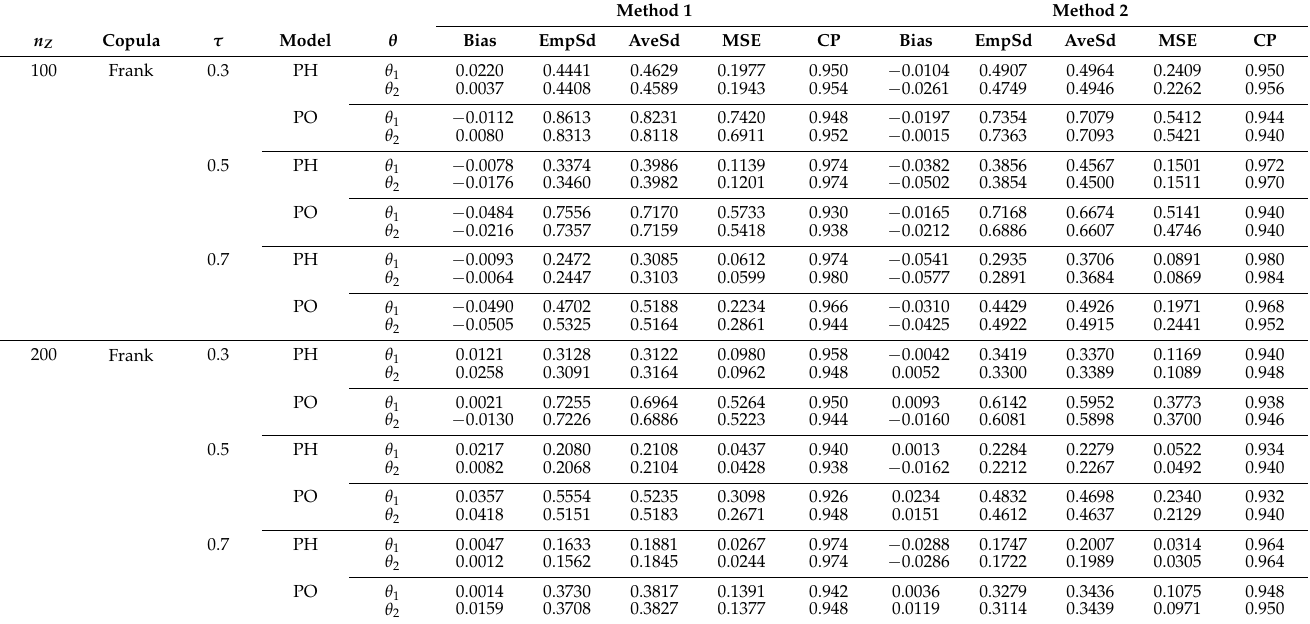
Table 8. The estimators of θ under Case 2 when the variable of interest is